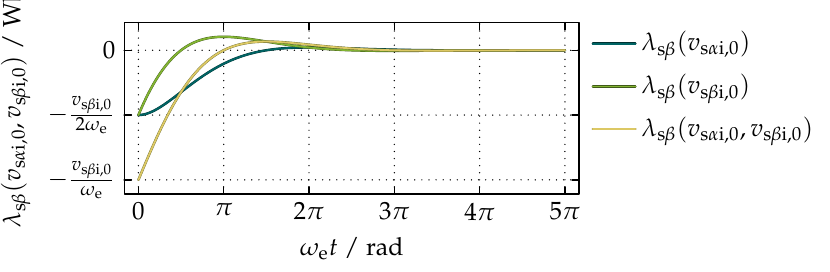
Figure 8. A plot of λ s β with the component λ s β ( v s α i,0 ) imposed by v s α i,0 and λ s β ( v s β i,0 ) imposed by v s β i,0 in the time-domain for a step excitation on both inputs with v s α i,0 = v s β i,0 .